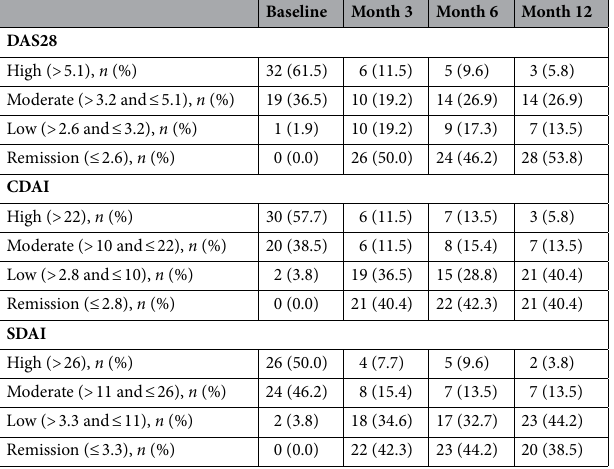
Table 2. Disease activity of the early RA patients. CDAI Clinical Disease Activity Index, DAS28 28-joint Disease Activity Score, SDAI Simplified Disease Activity Index.